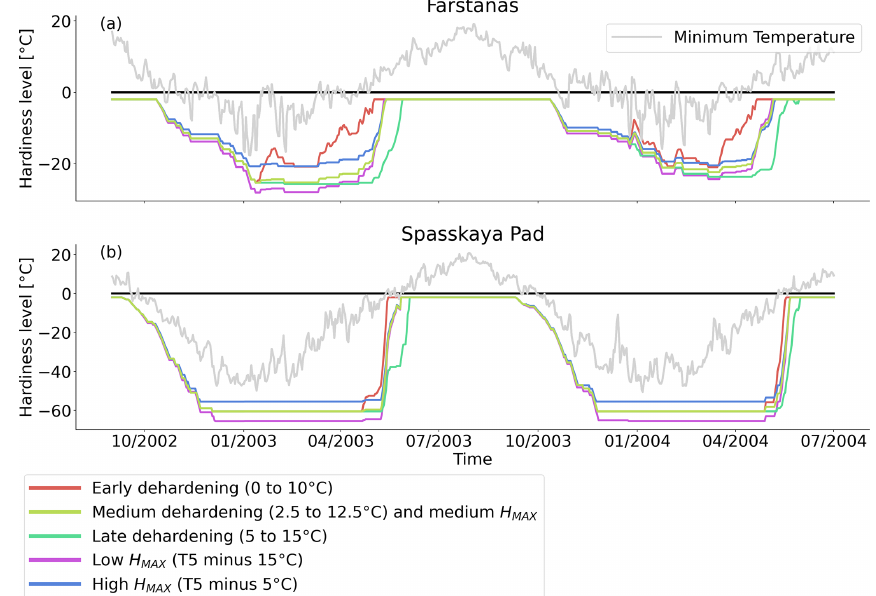
Figure 10. Hardiness level from dehardening and maximum hardiness level sensitivity analysis simulations for needleleaf evergreen trees at the sites of (a) Farstanäs and (b) Spasskaya Pad during the period September 2002–July 2004. The grey line corresponds to the minimum daily temperature, the black line is 0 ◦ C, and the colored lines are the dehardening and maximum level hardiness sensitivity